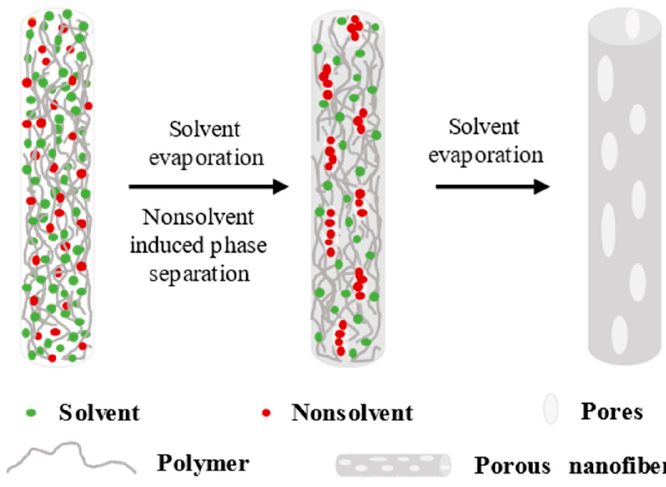
Figure 4. Schematic of the pore − forming mechanism of NIPS.